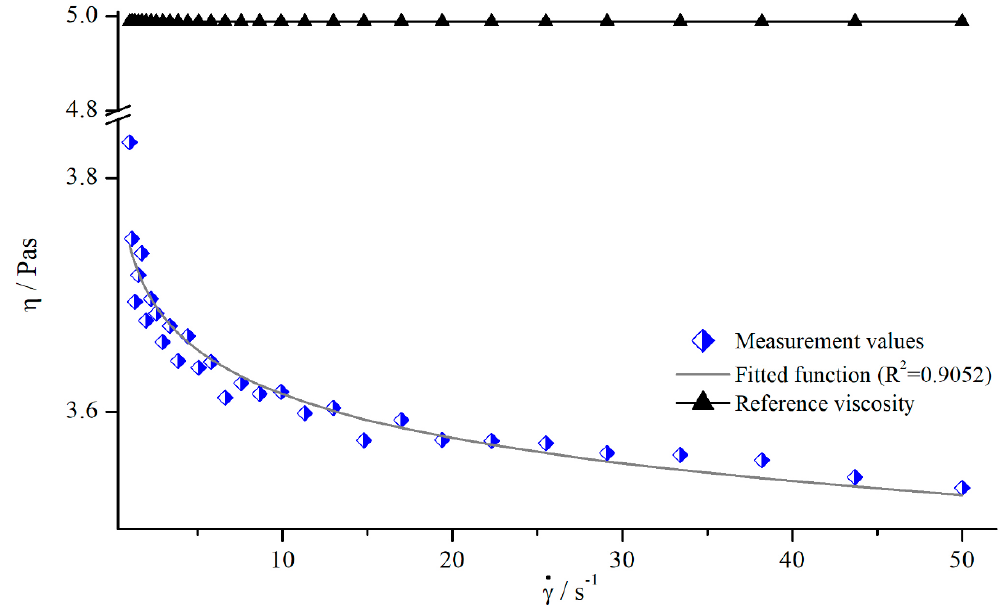
Figure 4. Comparison between apparent shear rate γ(cid:4662) (cid:2911) and true shear rate γ(cid:4662) in the velocity profile between two parallel plates showing wall slip, measured with columns (system 6), bars (system 12), and pyramids (system 2).